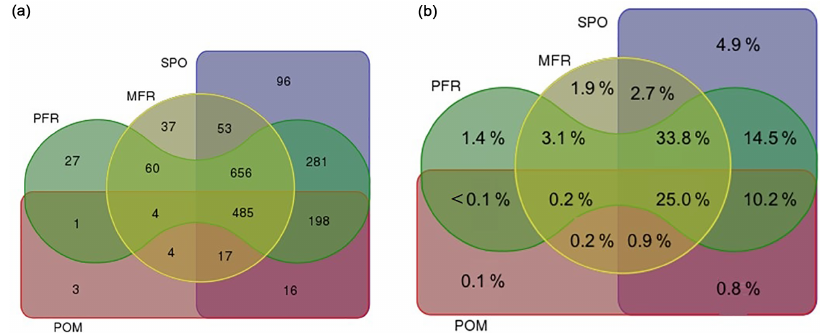
Figure 7. Venn diagram of quality-controlled, clear-sky datasets of SPO, MFR, PFR and POM data for four cloudless (only very limited presence of clouds) days. (a) Number of measurements, (b) percentage of measurements.